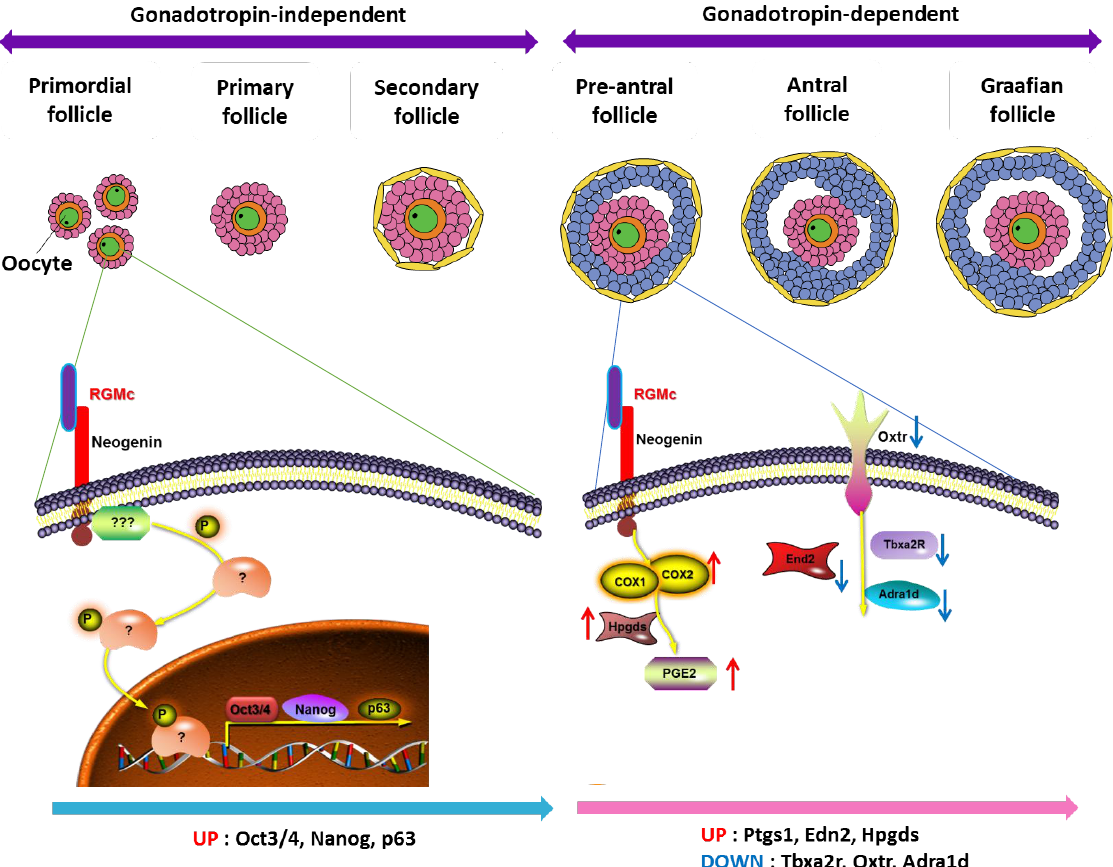
Figure 8. Schematic illustration of the signaling pathway by which the neogenin ligand RGMc enhances follicular development.